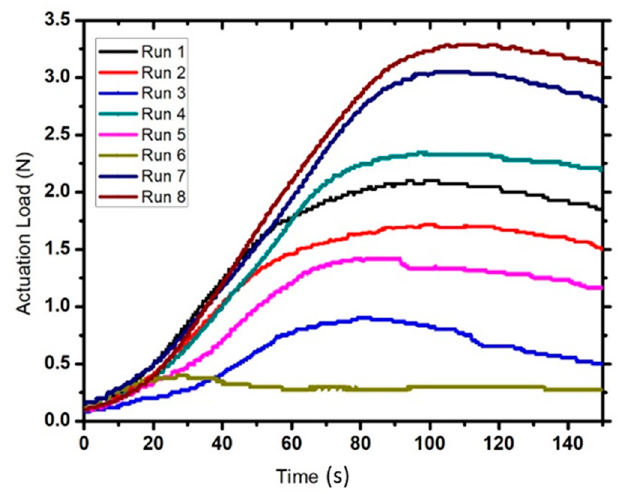
Figure 9. Actuation load curves for each experiment.